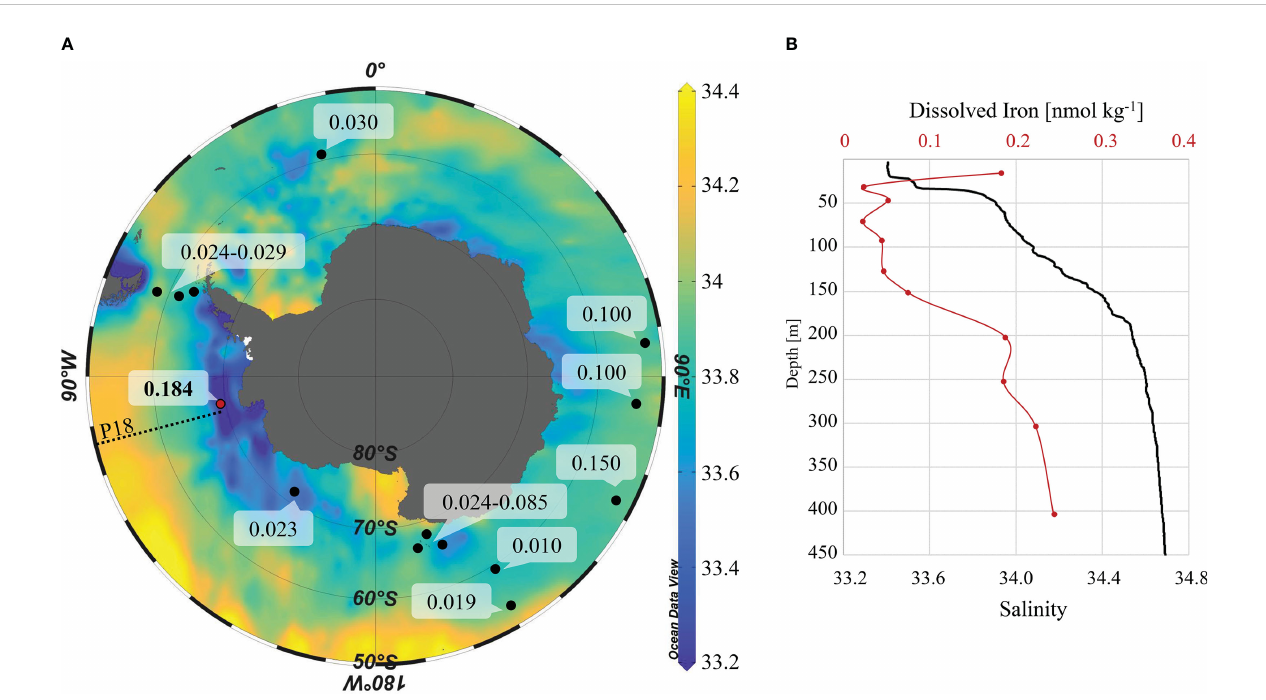
FIGURE 6 (A) Dissolved iron [nmol kg -1 ] concentrations at 15 meters from GEOTRACES cruise GSci01 (Walton and Thomas, 2018) occupied between 20/12/2016 to 19/01/2017 (black dots and white call boxes) overlayed on surface salinity data (<5 m) from 10,361 stations sampled between December 1 st and March 1 st (austral summer). Salinity data were compiled from GLODAP, PACIFICA, and Southern Ocean Atlas Databases (Webb, 1994; Suzuki et al., 2013; Key, 2015; Olsen et al., 2016). (B) Dissolved iron concentration pro fi le from station 68 (69°S, 100°W; red line) on cruise GSci01 and CTD salinity data from 2017 P18 (69°S, 103°W; black line). GSci01 salinity data are not displayed, as measurements above 15 m were not